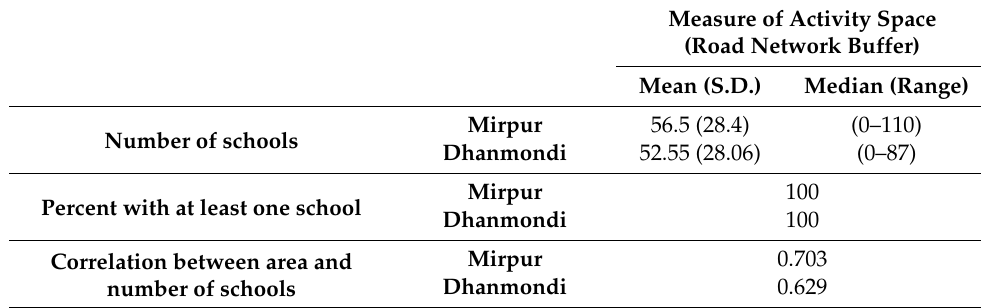
Table 6. Area-wise access to opportunity (school) for road network